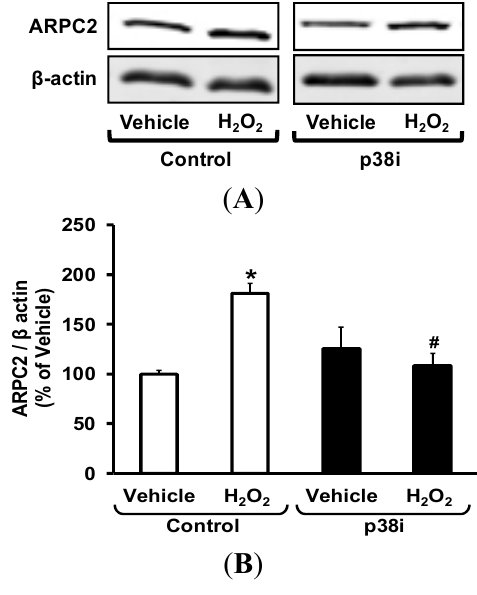
Figure 7. Inhibition of p38 MAPK pathway attenuates H VSMC were pre-treated with the p38 MAPK inhibitor (p38i) SB203580 (1 μ M, 1 h, Millipore), followed by treatment with vehicle or H were subjected to Western blot and probed with polyclonal antibodies against ARPC2 and β -actin. ( A ) Representative Western blot showing ARPC2 and β -actin expression in control- and p38i-treated VSMC incubated with vehicle or H representing averaged optical density data expressed as a ratio of ARPC2 to β -actin ( n = 4). Data represent the mean ± SEM. * p < 0.05 vs . Control + vehicle treatment. # p < 0.05 vs . O Control + H 2 2